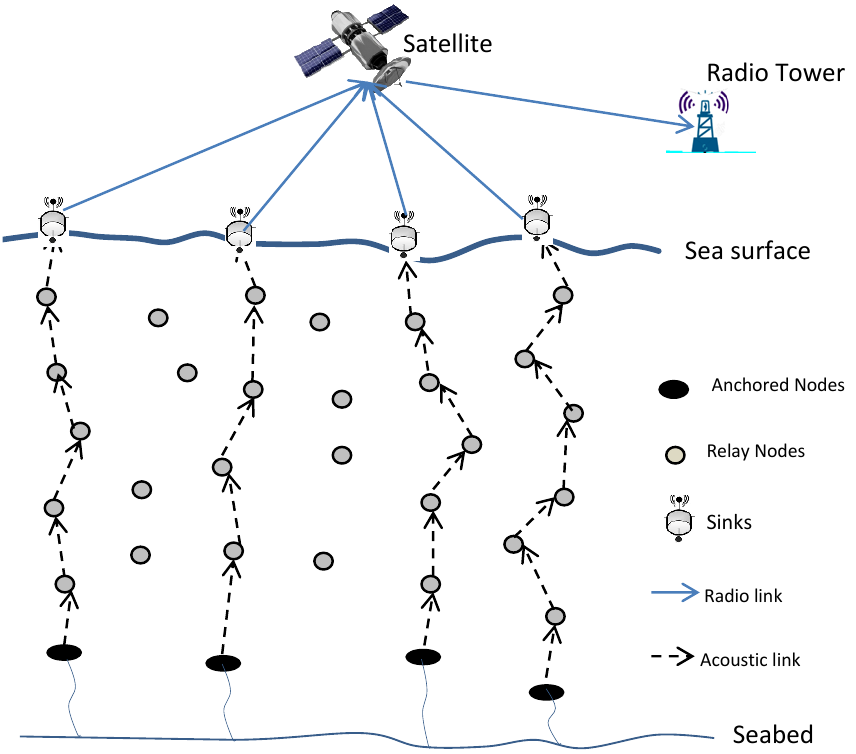
Figure 14. EBER 2 Network Topology.